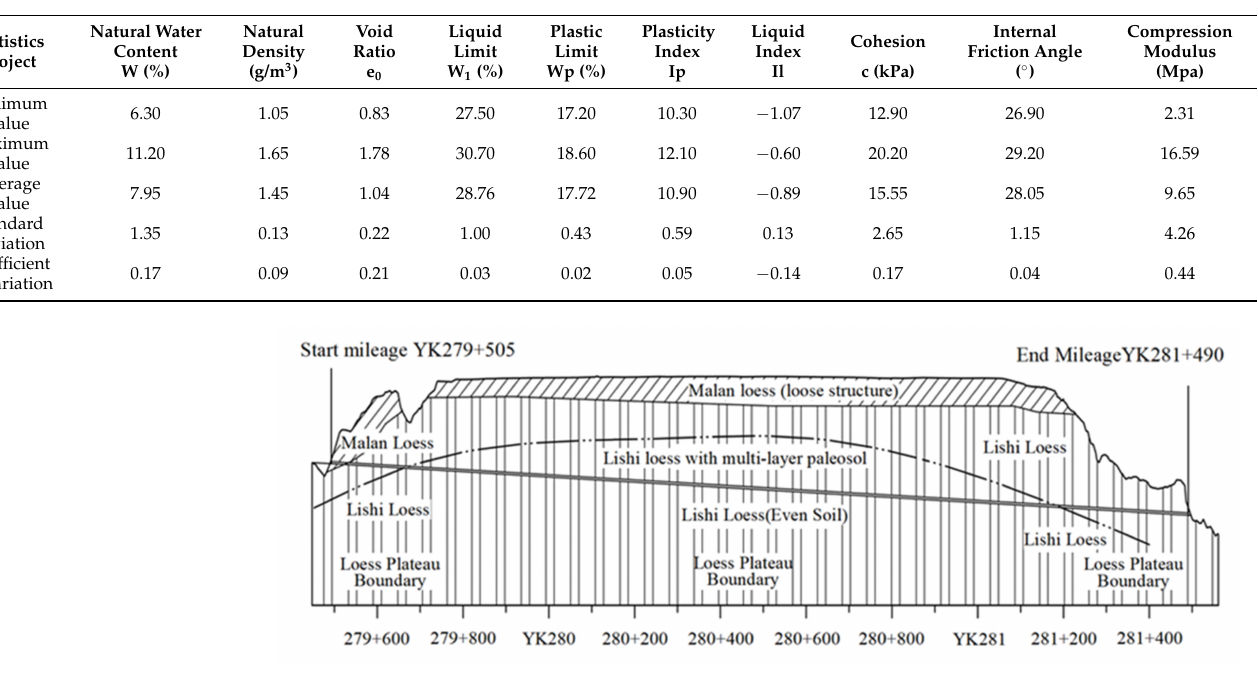
Figure 1. Geological section of Yulinzi